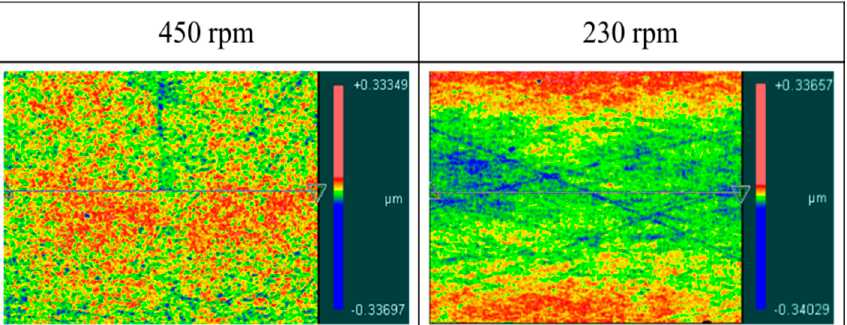
Figure 7. Macroscopic confocal images of the finished surface after the 60-min MAF process under the conditions of various rotational speeds of the machining tool.